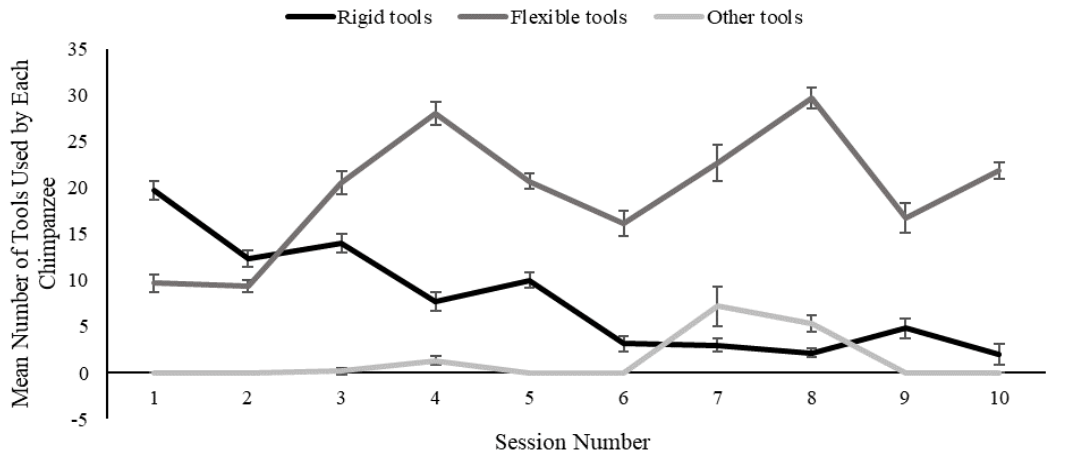
The Mean Number of Dips (Successful and Unsuccessful Combined) Made with Each Tool Type per Chimpanzee per Session Error Bars show the Standard Error of the